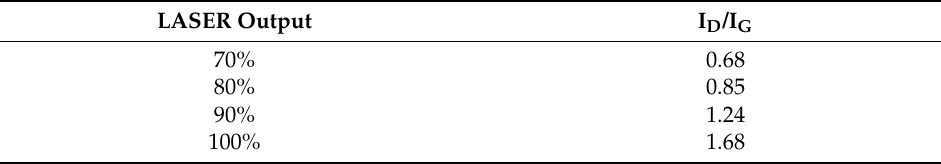
Figure 4. Raman spectra of carbon-doped SUS304 by laser output. Table 3. I D /I G of carbon-doped SUS304 by laser